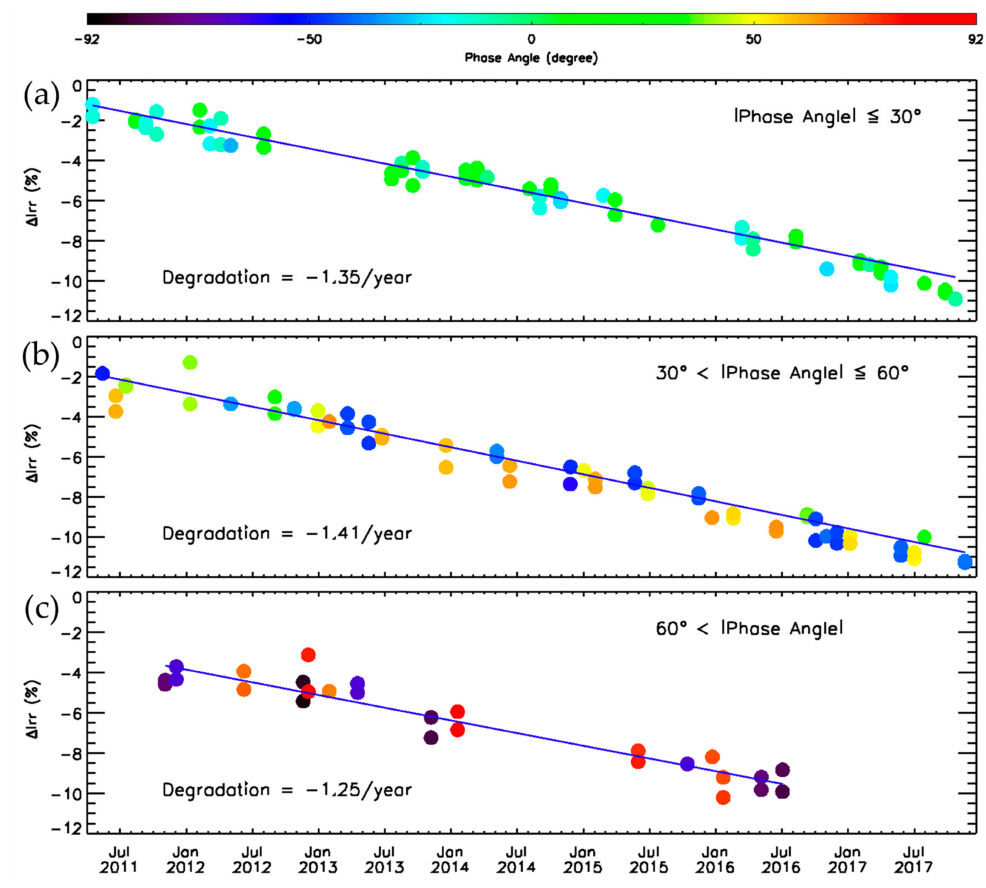
Figure A3. Degradation ratio as a result of phase angle range of COMS MI; (a) absolute phase angle ≤